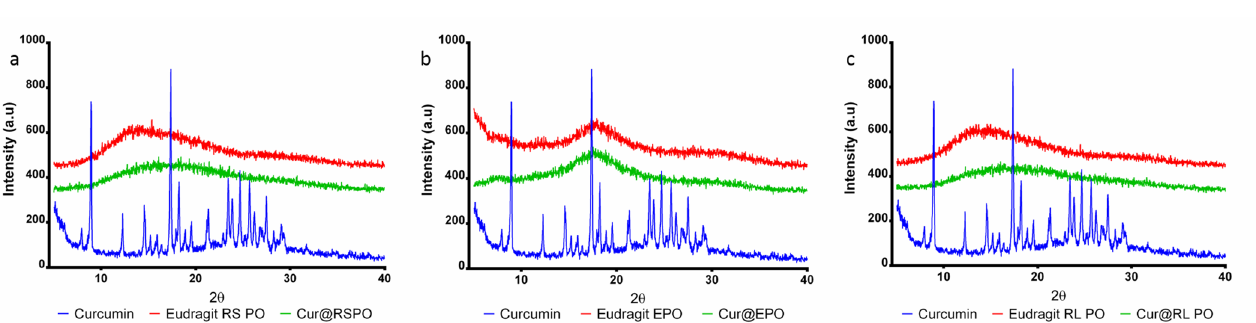
FIGURE 3 - X-Ray diffraction (XRD) profiles of a: curcumin, Eudragit RS PO and curcumin Eudragit RS PO solid dispersion; b: curcumin, Eudragit E PO and curcumin Eudragit E PO solid dispersion; c: curcumin, Eudragit RL PO and curcumin Eudragit RL PO solid